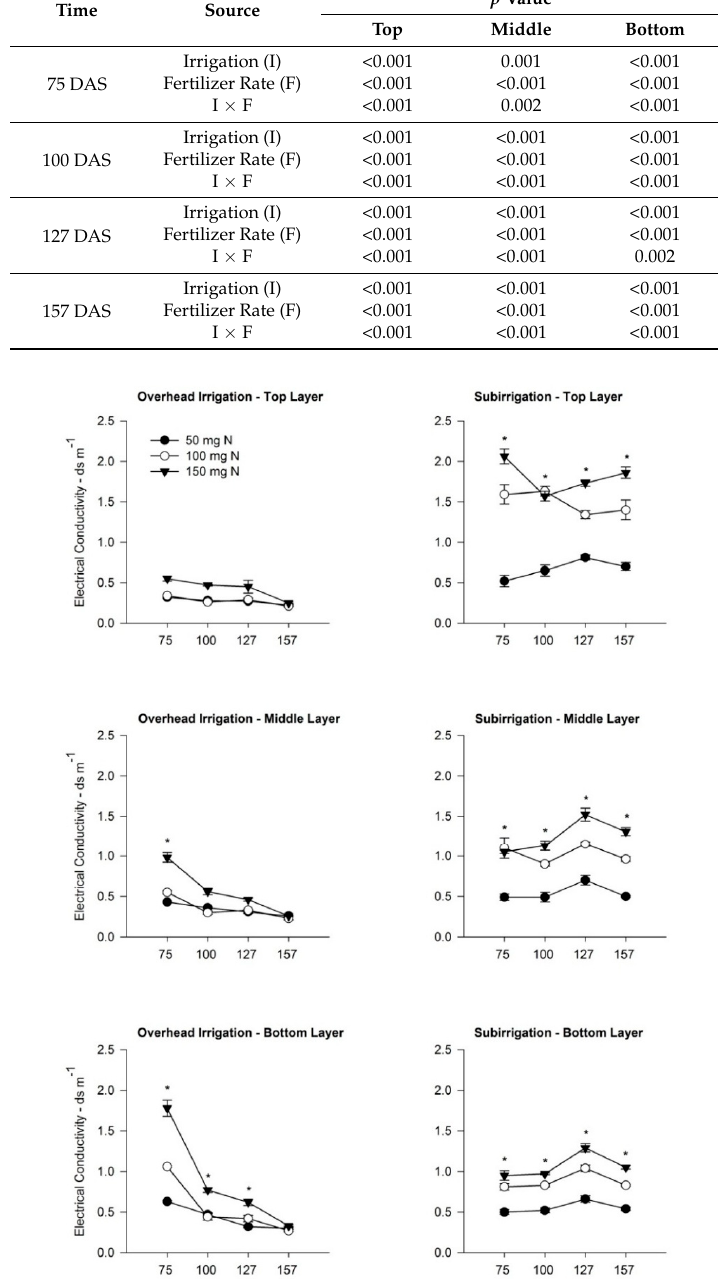
Figure 2. Electrical conductivity (EC, ds m − 1 ) from days 75 to 157 of growing media as measured at three depths (top (3 cm), middle (10 cm), and bottom (17 cm)) in the seedling containers for each combined irrigation method and fertilizer rate treatment. An asterisk indicates a significant difference within a given irrigation treatment and media layer according to Tukey’s honestly significant difference test at α = 0.05.